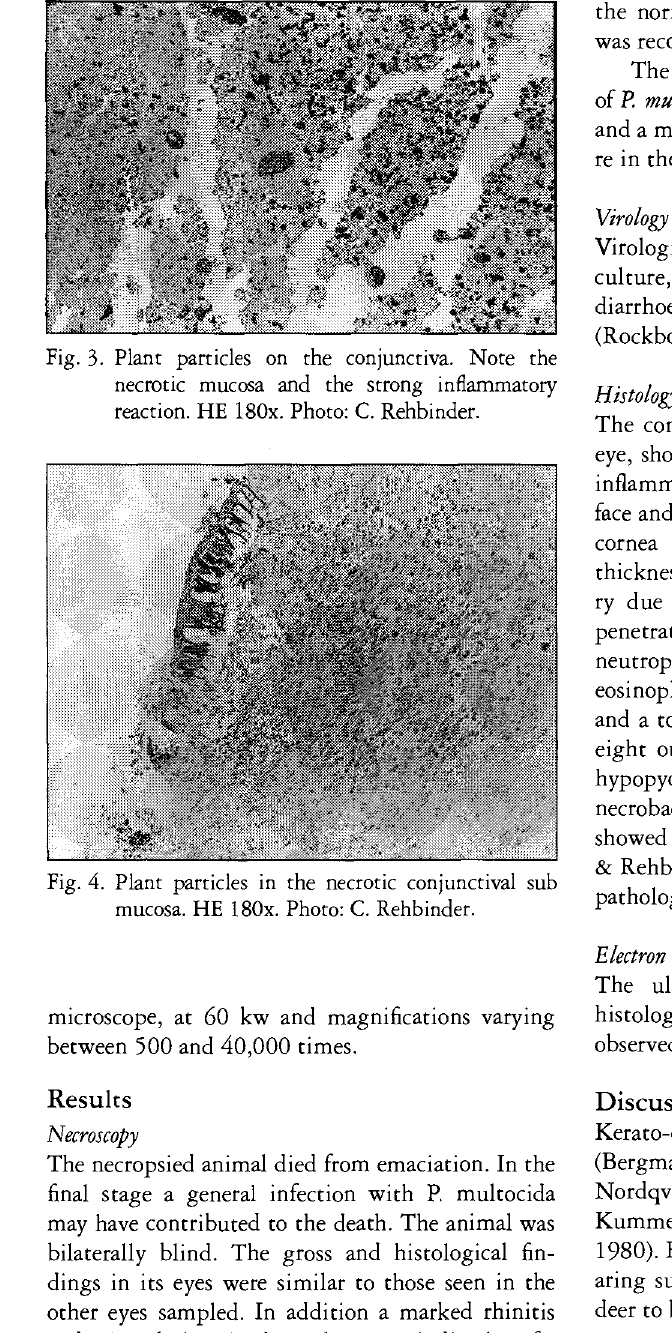
Fig. 3. Plant particles on the conjunctiva. Note the necrotic mucosa and the strong inflammatory reaction. HE 180x. Photo: C. Rehbinder.